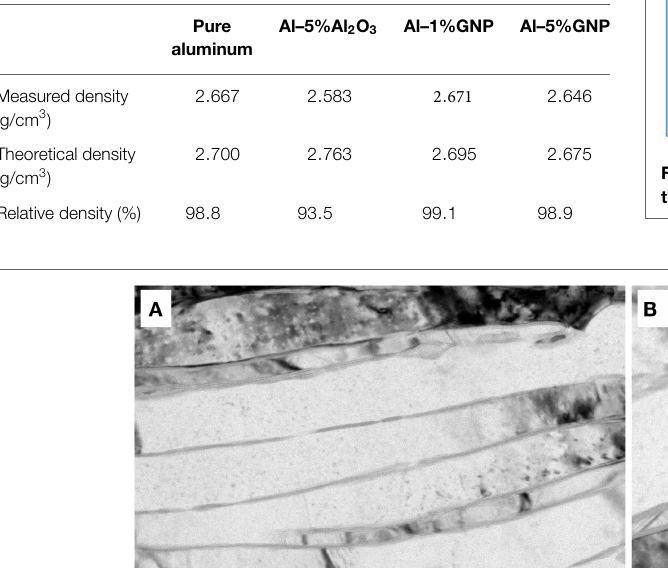
Fr ontiers in Materials |